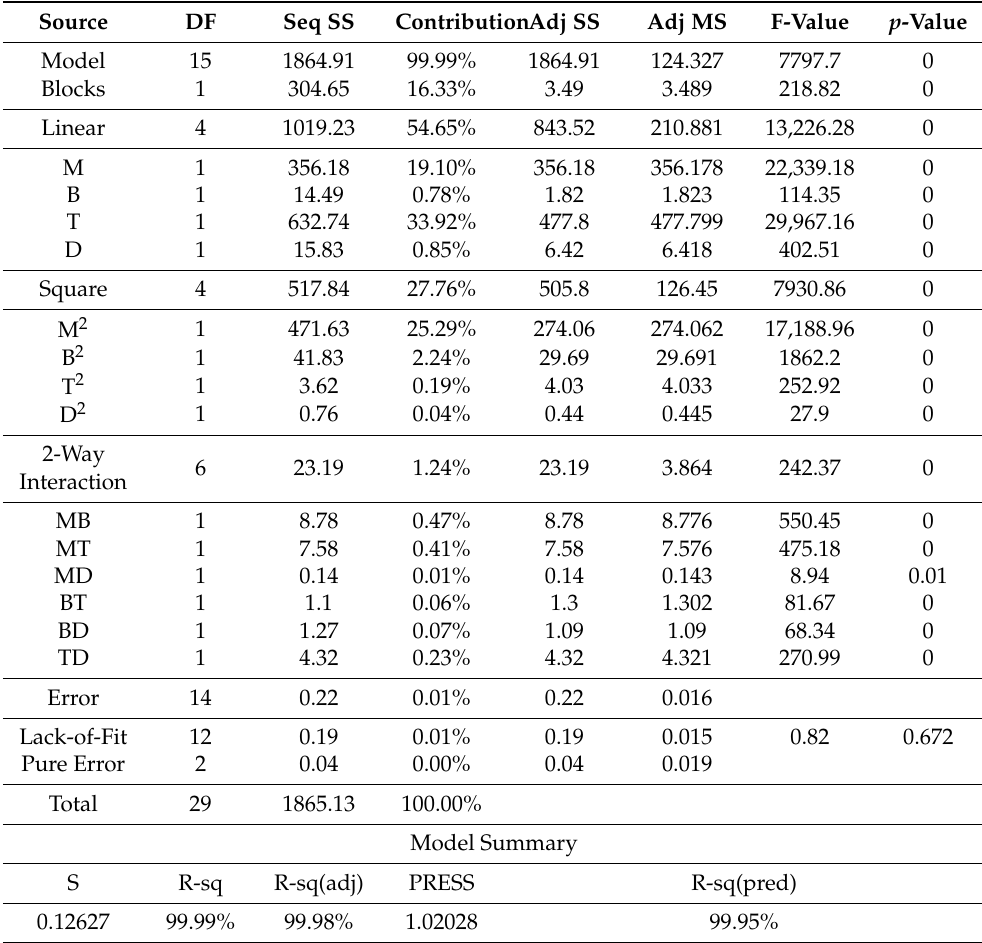
Table 15. The ANOVA test of the transesterification process yield prediction (coded parameters).